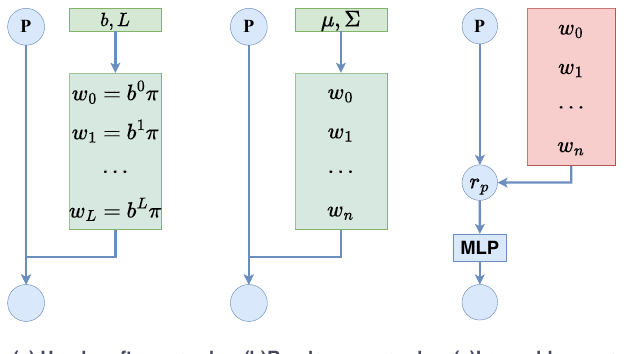
Figure 3. The structures of three positional encoding methods. The blue circle P represents the coordinate. The green rectangles indicate the hyperparameters of the Fourier features. The red rectangle indicates the learnable